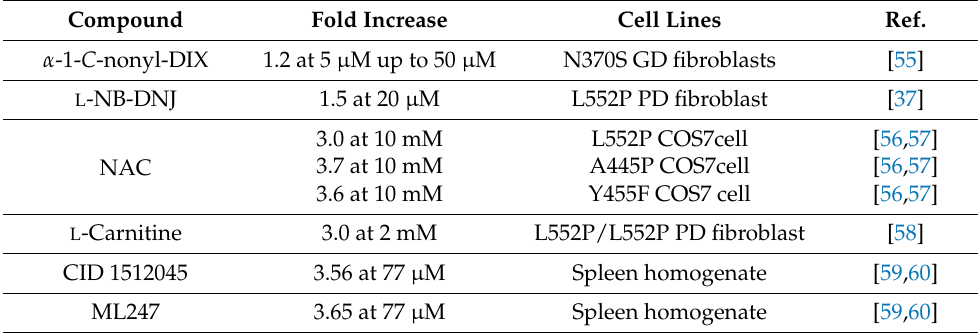
Table 2. Non-inhibitory PCs for